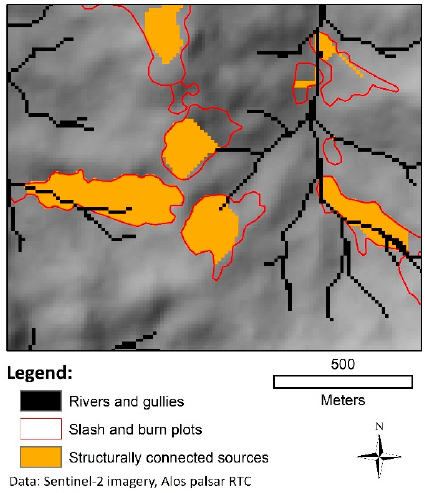
Figure 5. Example of sediment source connection mapping using a watershed geoprocessing tool.